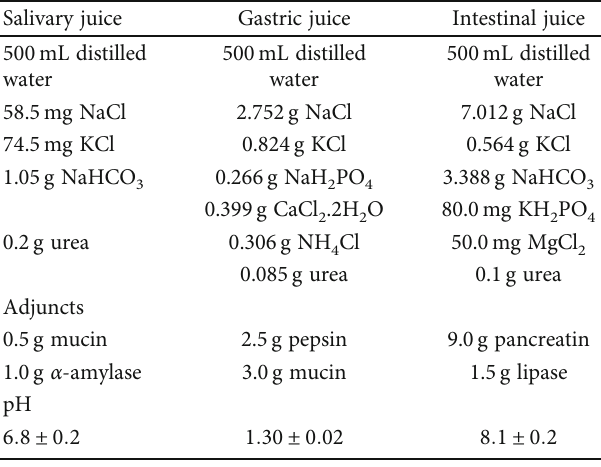
Table 3: Composition of simulated digestive juices. Salivary